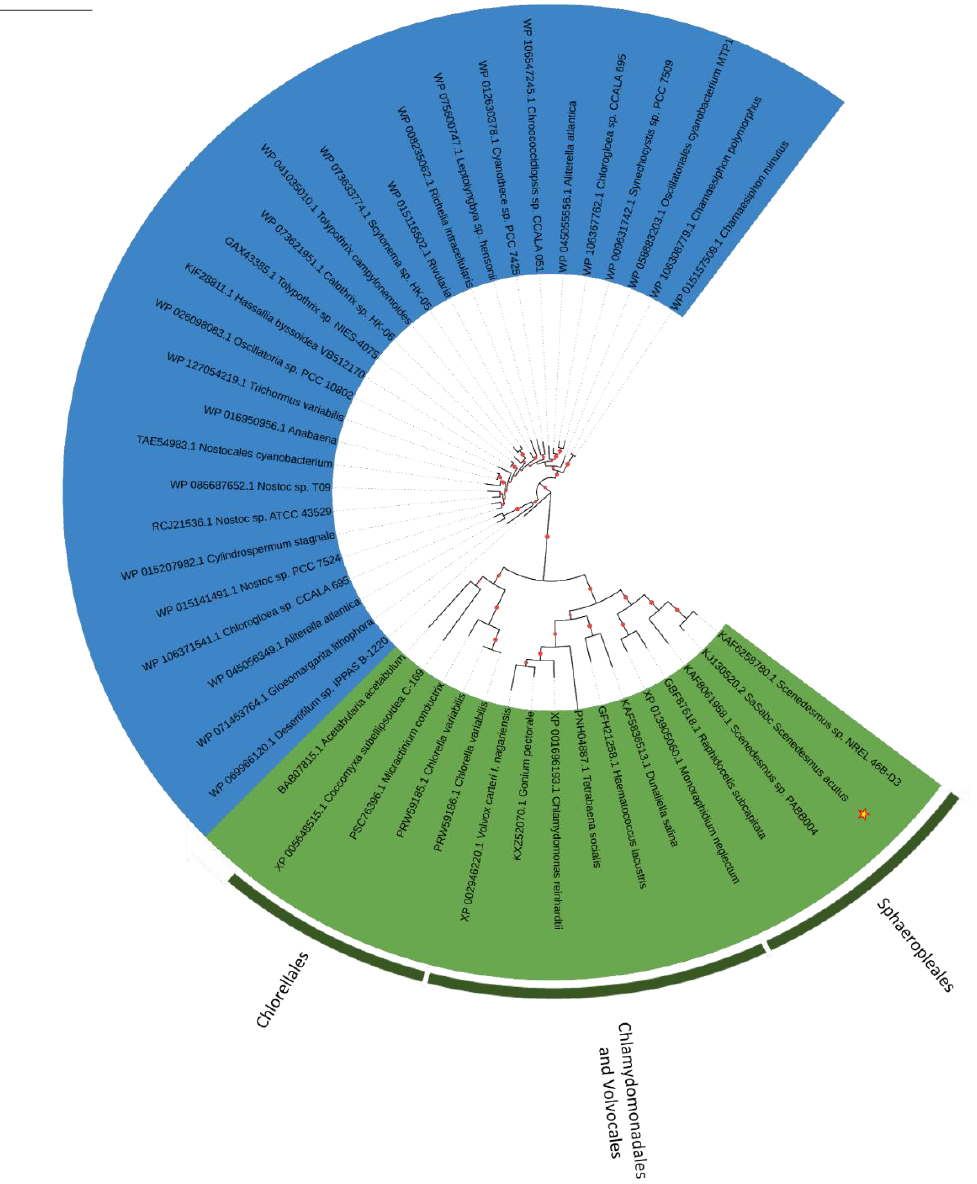
Figure 8. The evolutionary history of Sabc. The tree with the highest log likelihood (−14 ,456.88) is shown. The percentage of trees in which the associated taxa clustered together is shown below the branches. The tree is drawn to scale, with branch lengths measured in the number of substitutions per site. This analysis involved 44 amino acid sequences (Table S1) for a total of 590 positions in the final dataset.